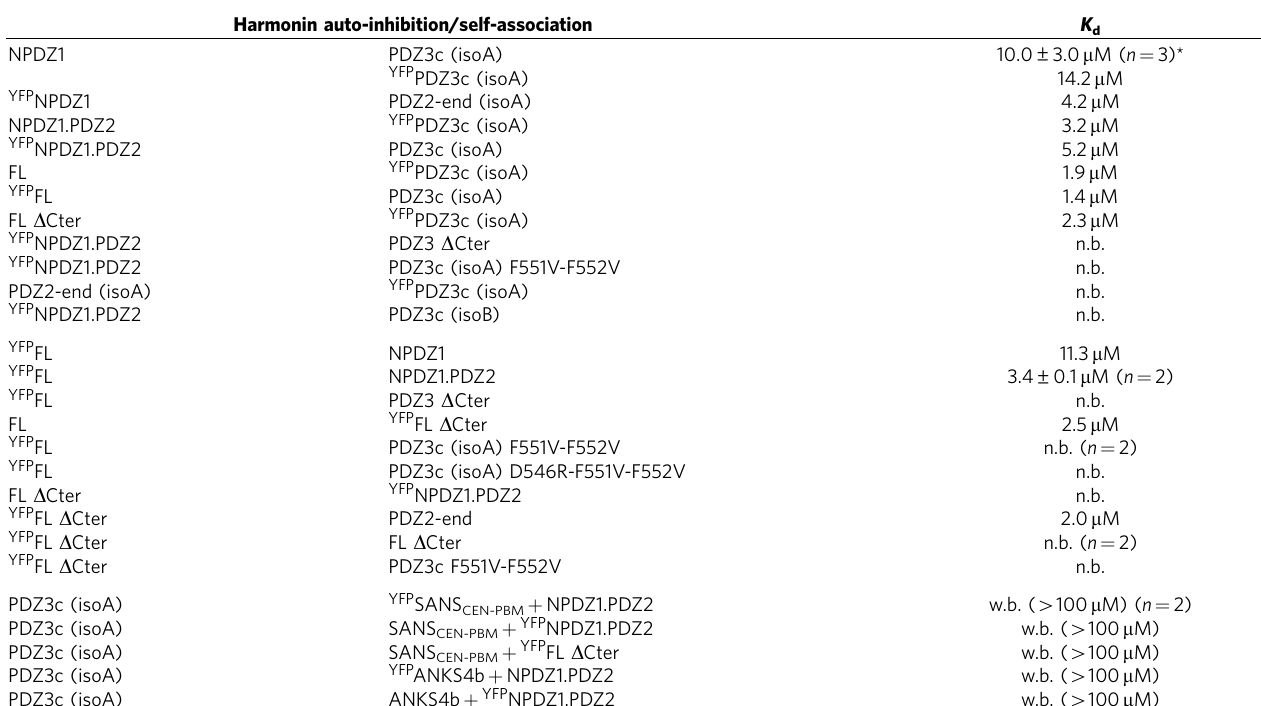
Table 5 | Characterization of harmonin interactions. Harmonin